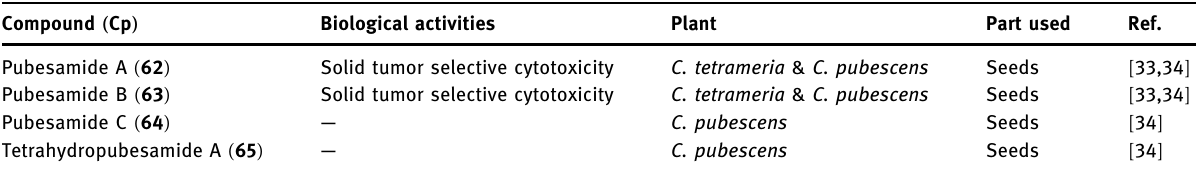
Table 18: Pharmacological properties of benzoyltyramide derivatives isolated from Casimiroa species Compound ( Cp )